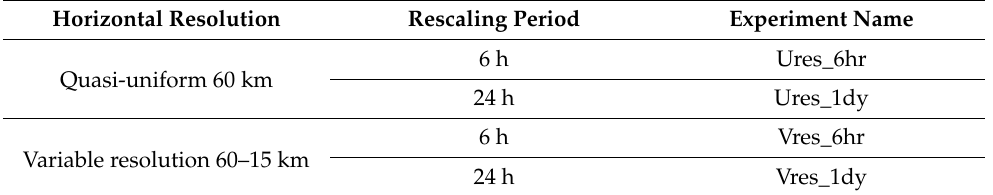
Table 2. Lists of four experiments under different settings of model resolution and rescaling